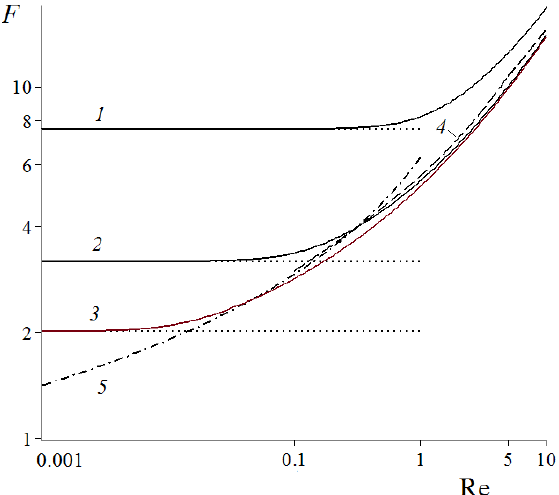
Figure 4. The fiber drag force in a row of fibers vs. the Reynolds number; in the case of low Reynolds numbers and sparse rows: a / h = 0.1 ( 1 ), 0.01 ( 2 ), 0.001 ( 3 ); 4 is given by the regression formula for an isolated cylinder, Equation (7) [32]; 5 is given by the Lamb formula for an isolated cylinder [33]; horizontal asymptotic lines ( )—values for the Stokes flow limit at Re << 1.